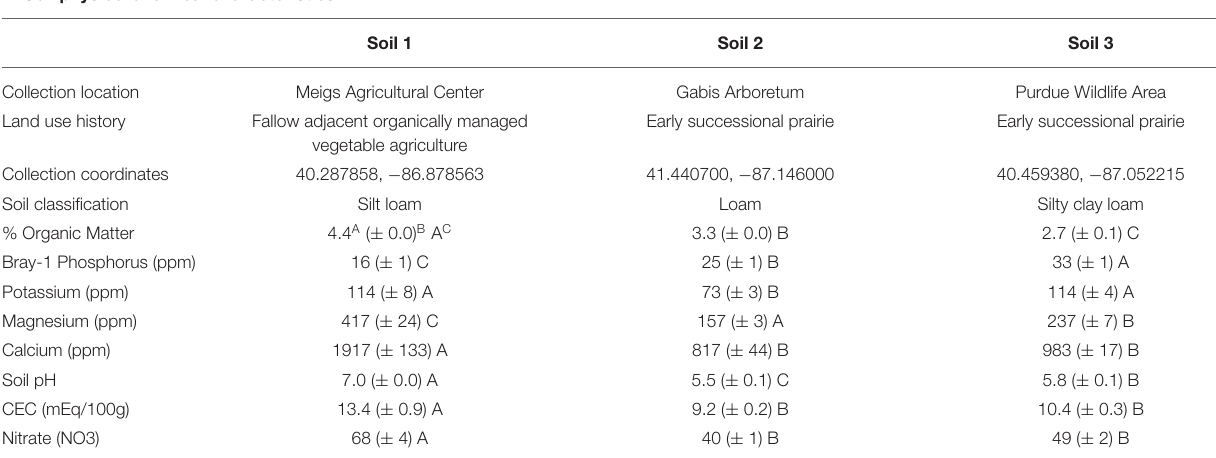
TABLE 1 | Soil physico-chemical and microbial community characteristics. A: Soil physico-chemical